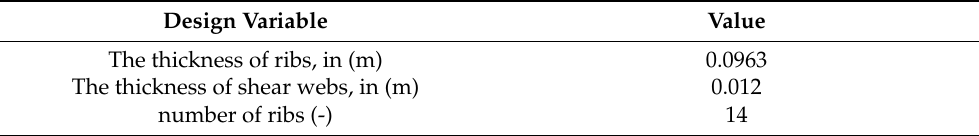
Table 5. The values of decision variables for the considered optimal solution.